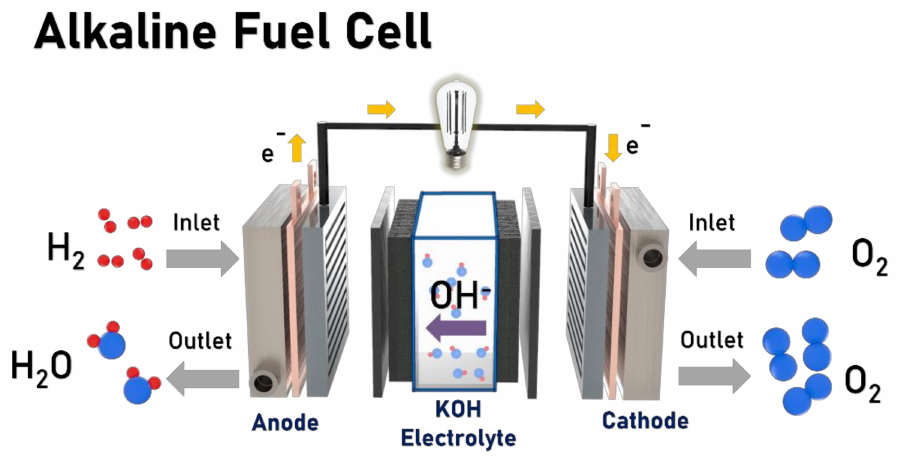
Figure 1. Schematic diagram of AFC.